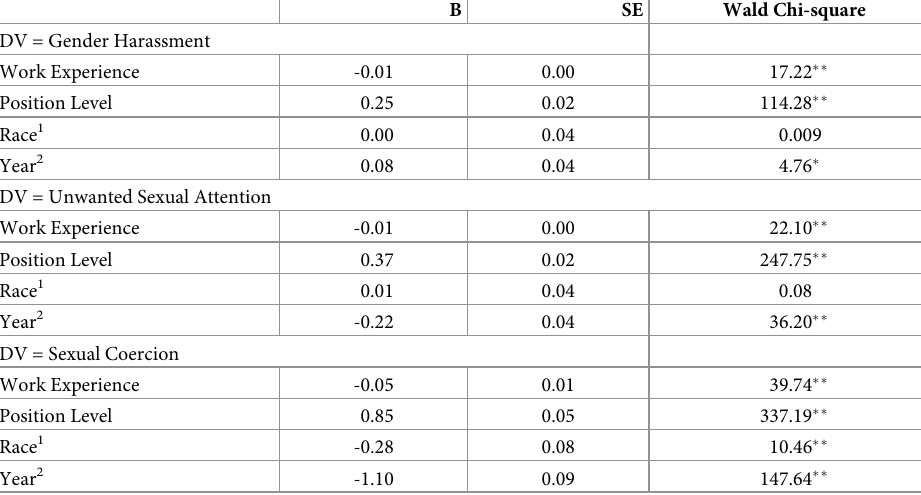
Table 3. Generalized Linear model using a Poisson distribution to examine changes in sexual harassment across year. The distribution of the sexual harassment variables most closely approximated a Poisson distribution given that the mode was zero, there was a strong positive skew, the data were not bimodal, and the mean and standard error were almost equal. Data are comprised for 513 women. 1 Race is coded as 0 = not White, 1 = White, 2 Year is coded as 0 =